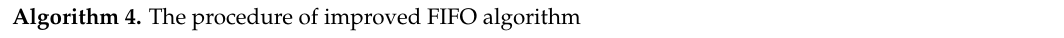
Algorithm 4. The procedure of improved FIFO algorithm